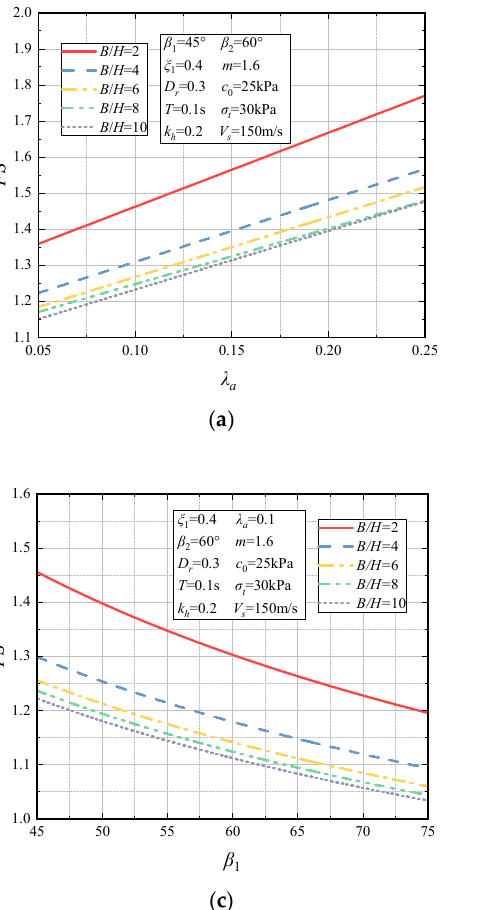
Figure 6. The interactions between the nonlinear factors on the stability for 3D two-step slopes: ( a ) nonlinear coefficient m and initial cohesion c 0 ; ( b ) nonlinear coefficient m and axial tensile strength σ t .